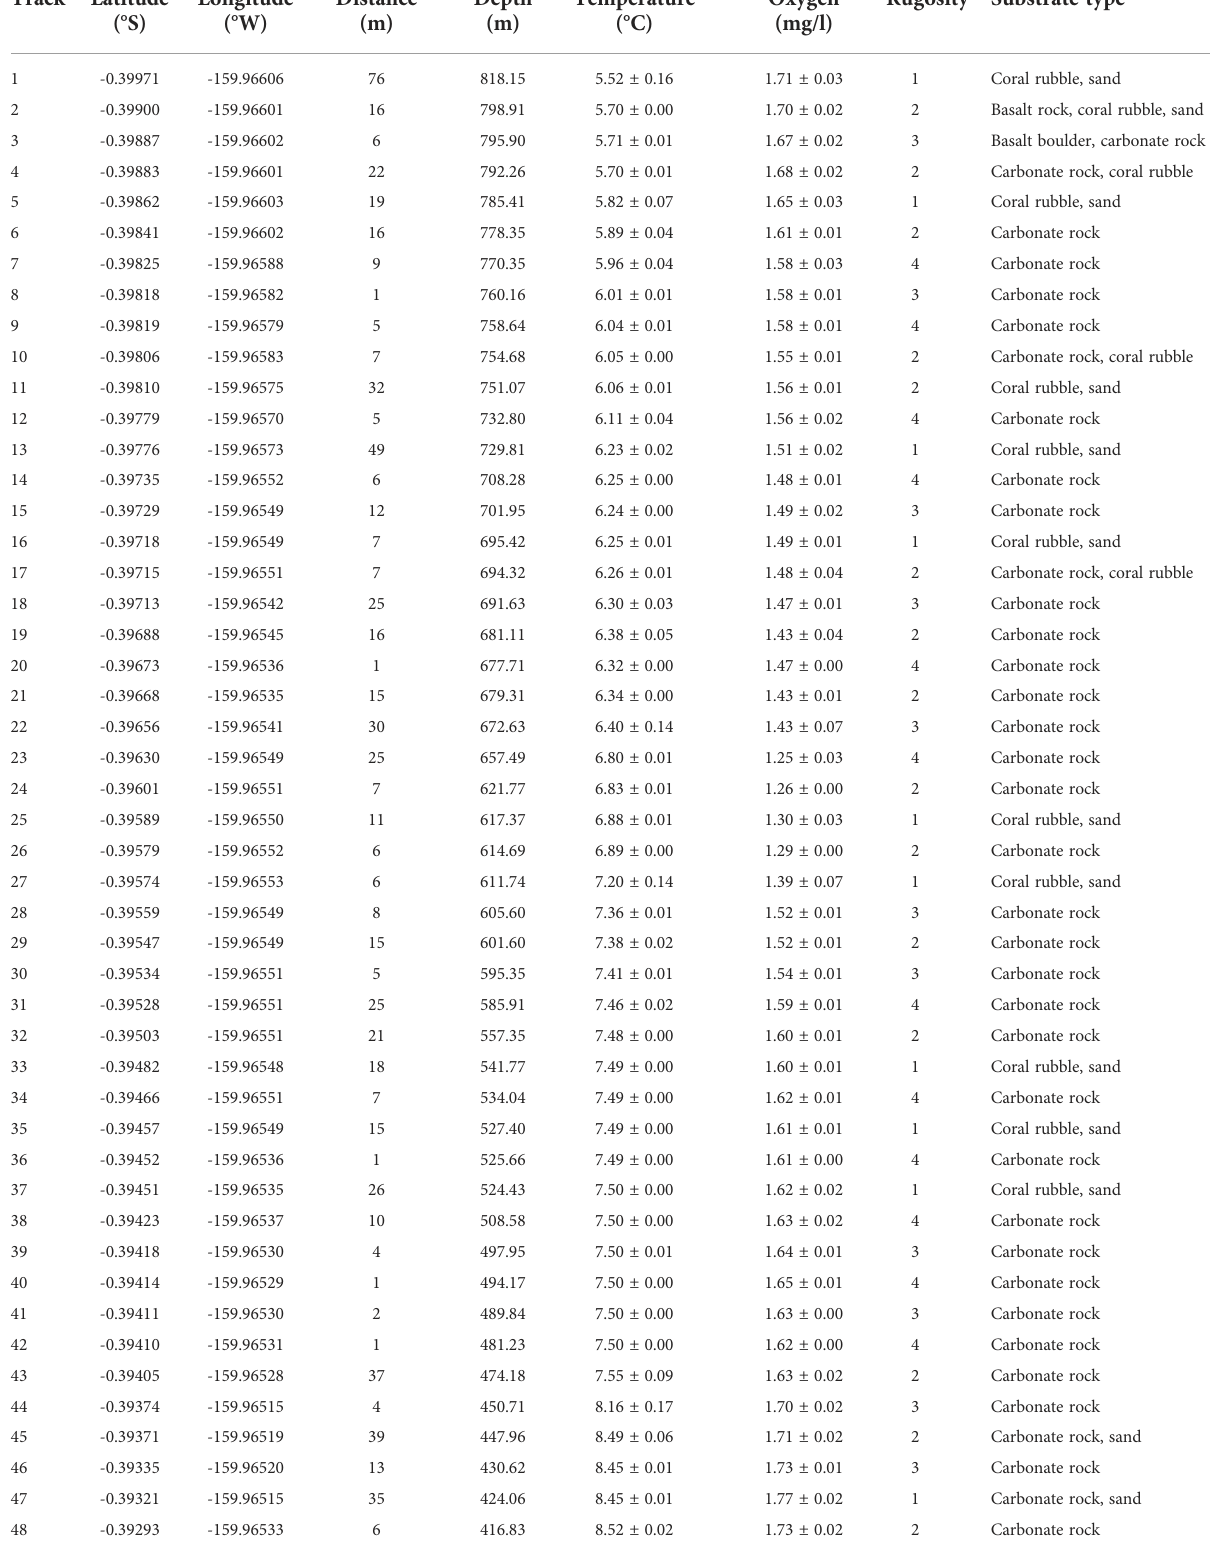
TABLE 1 Dive tracks of consistent rugosities identi fi ed on Dive 05 Jarvis Island, NOAA Ocean Exploration,